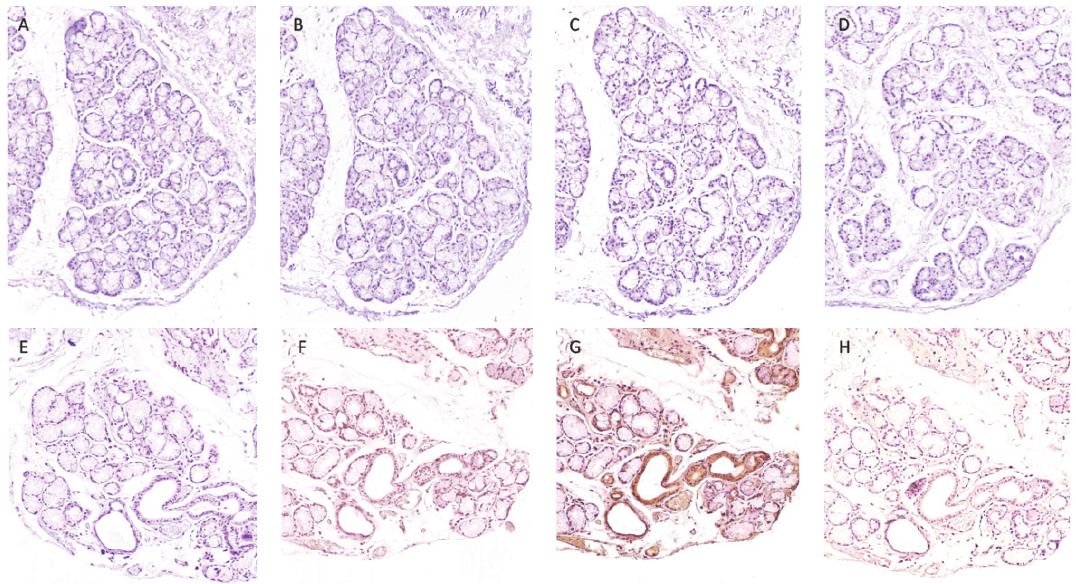
Figure 2: Immunohistochemistry of minor salivary glands. The superiorpanel corresponds to normal controls, and the inferiorpanel belongs toonerepresentativebiopsyofaSj¨ogrenpatient.(A)and(E).IncubatedwithPBS.(B)and(F).Treatedwithanti-CCP.(C)and(G).Anti-PAD2. (D) and (H). Anticitrulline. Observe the immunoreagents positivity at ducts and acini in (F), (G), and (H).